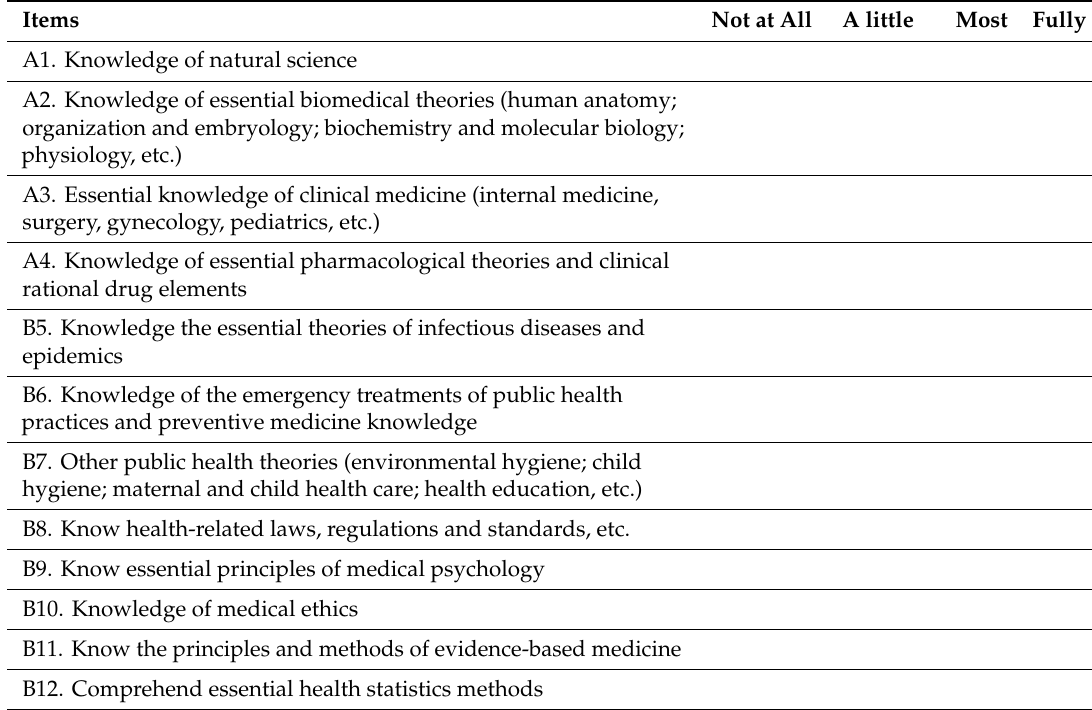
Table A2. Original instrument for clinical